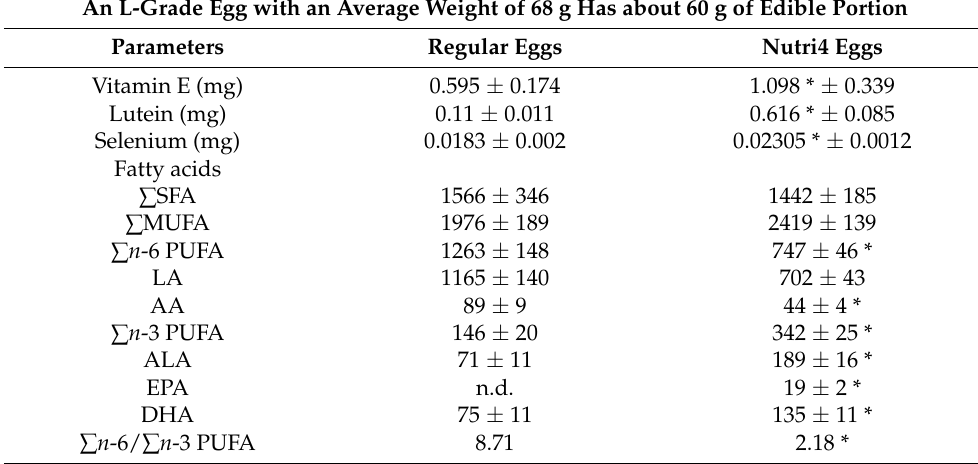
Table 1. Composition of micronutrient ingredients in Regular eggs and Nutri4